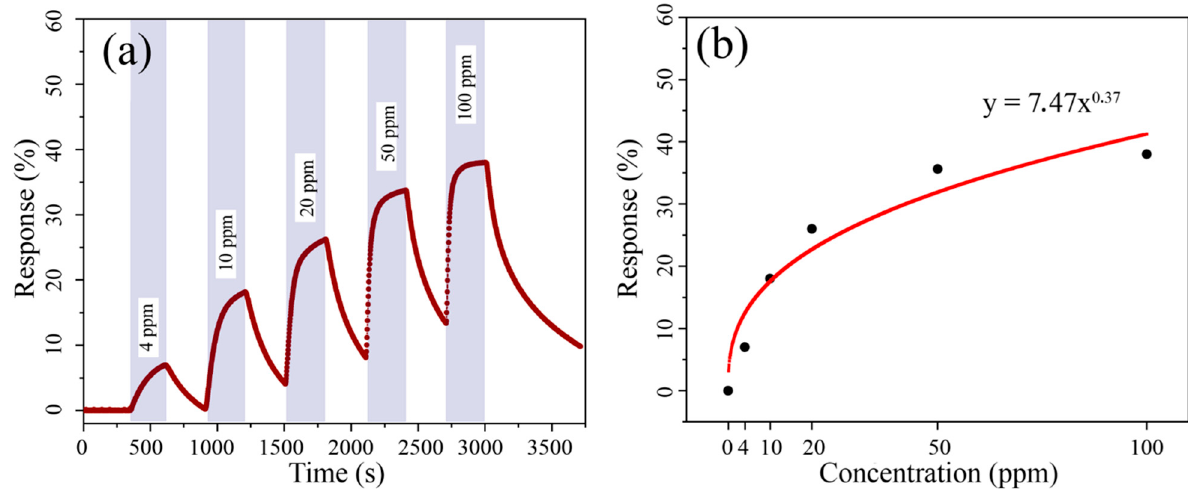
Figure 7. Experimental curves of changes in sensing response during detection of benzene in the concentration range of 4–100 ppm ( a ); Dependence of sensing response to benzene from its concentration ( b ).